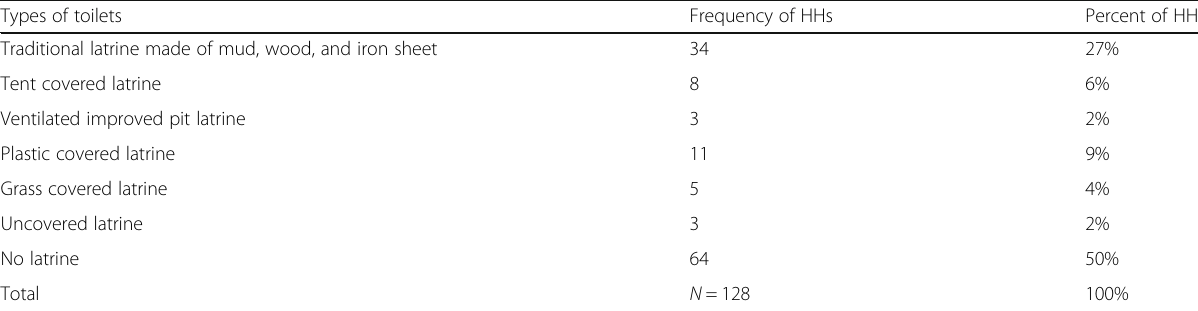
Table 2 Types of toilets used by